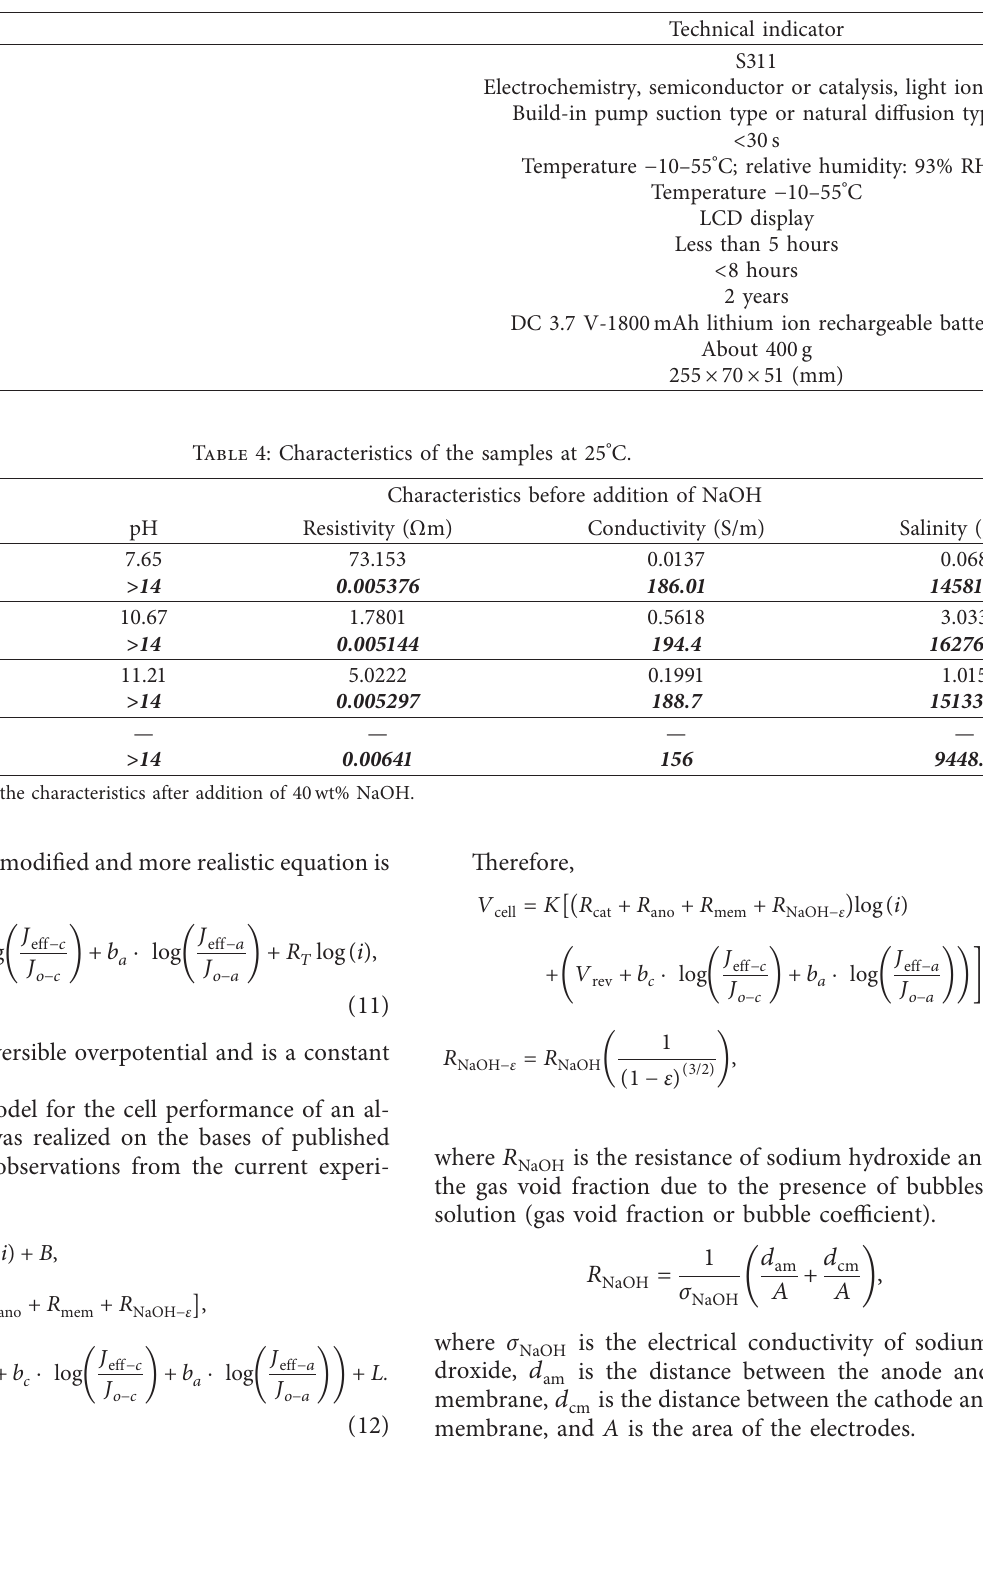
Table 3: Specifications of the hydrogen detector.